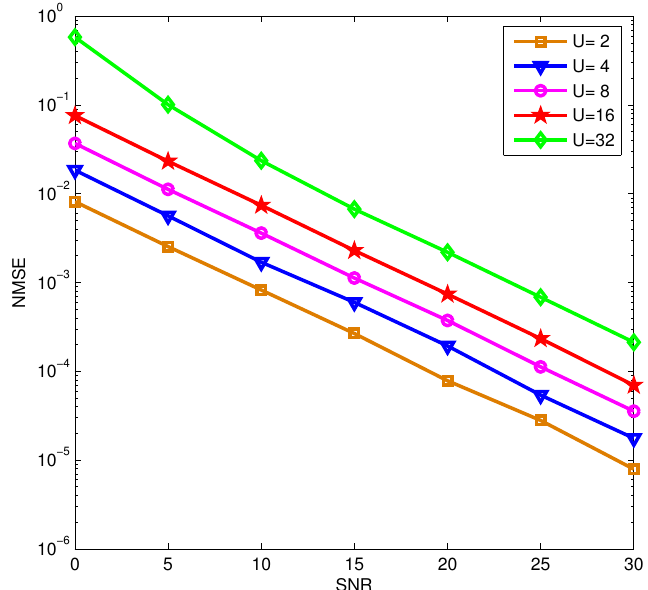
Figure 5. NMSE comparison of the proposed algorithm versus the number of